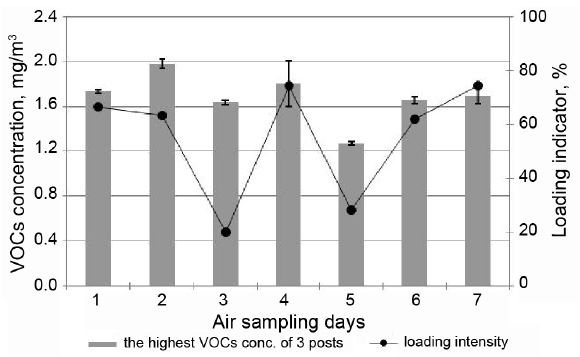
Fig. 4. Dispersion of VOCs concentration and loading indicator in summer